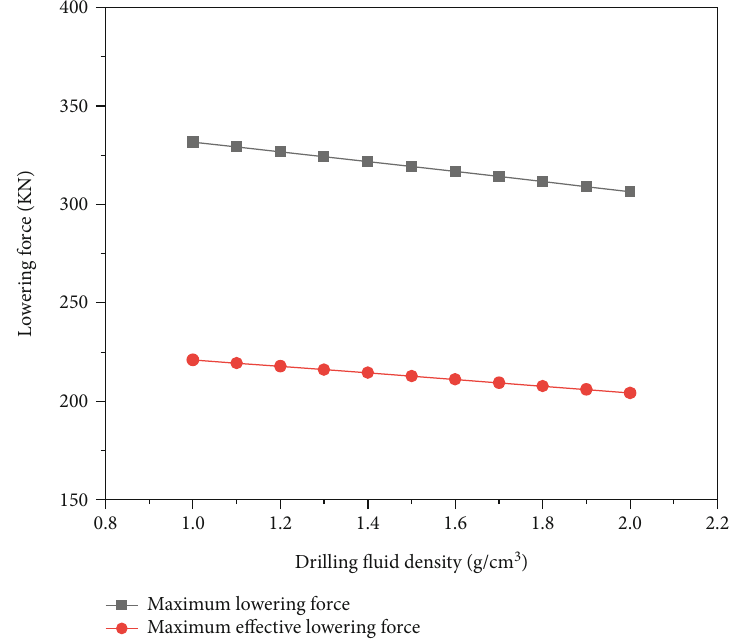
Figure 12: Lowering force on the casing string for di ff erent drilling fl uid